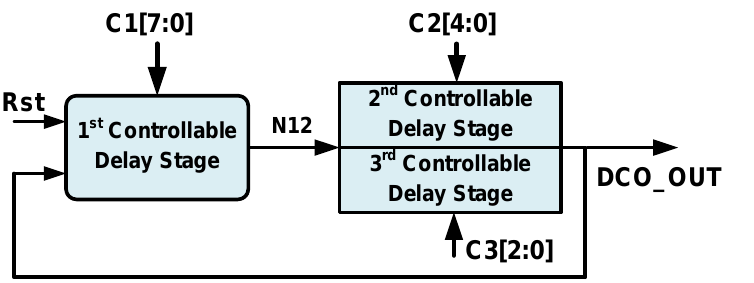
Figure 3. The proposed DCO architecture.